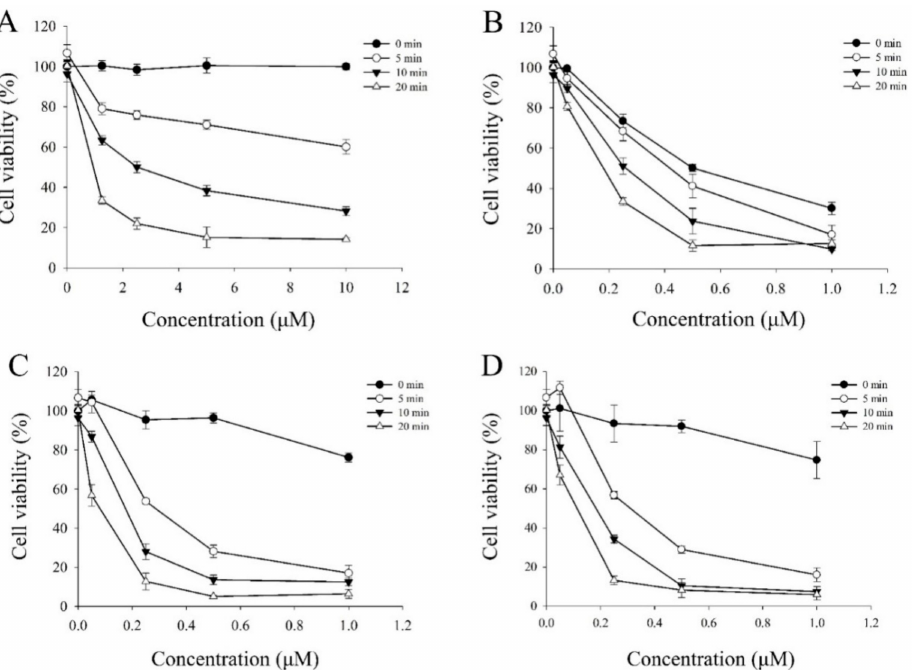
Figure 5. In vitro photocytotoxicity of HepG2 cells incubated with ( A ) berberine ( 1 ), ( B ) 5e , ( C ) 6e, and ( D ) 7e at various concentration for 4 h and then illuminated under a visible light (420 nm) for 5, 10, 20 min, or no light (dark series). The error bars denote the standard derivation of three independent